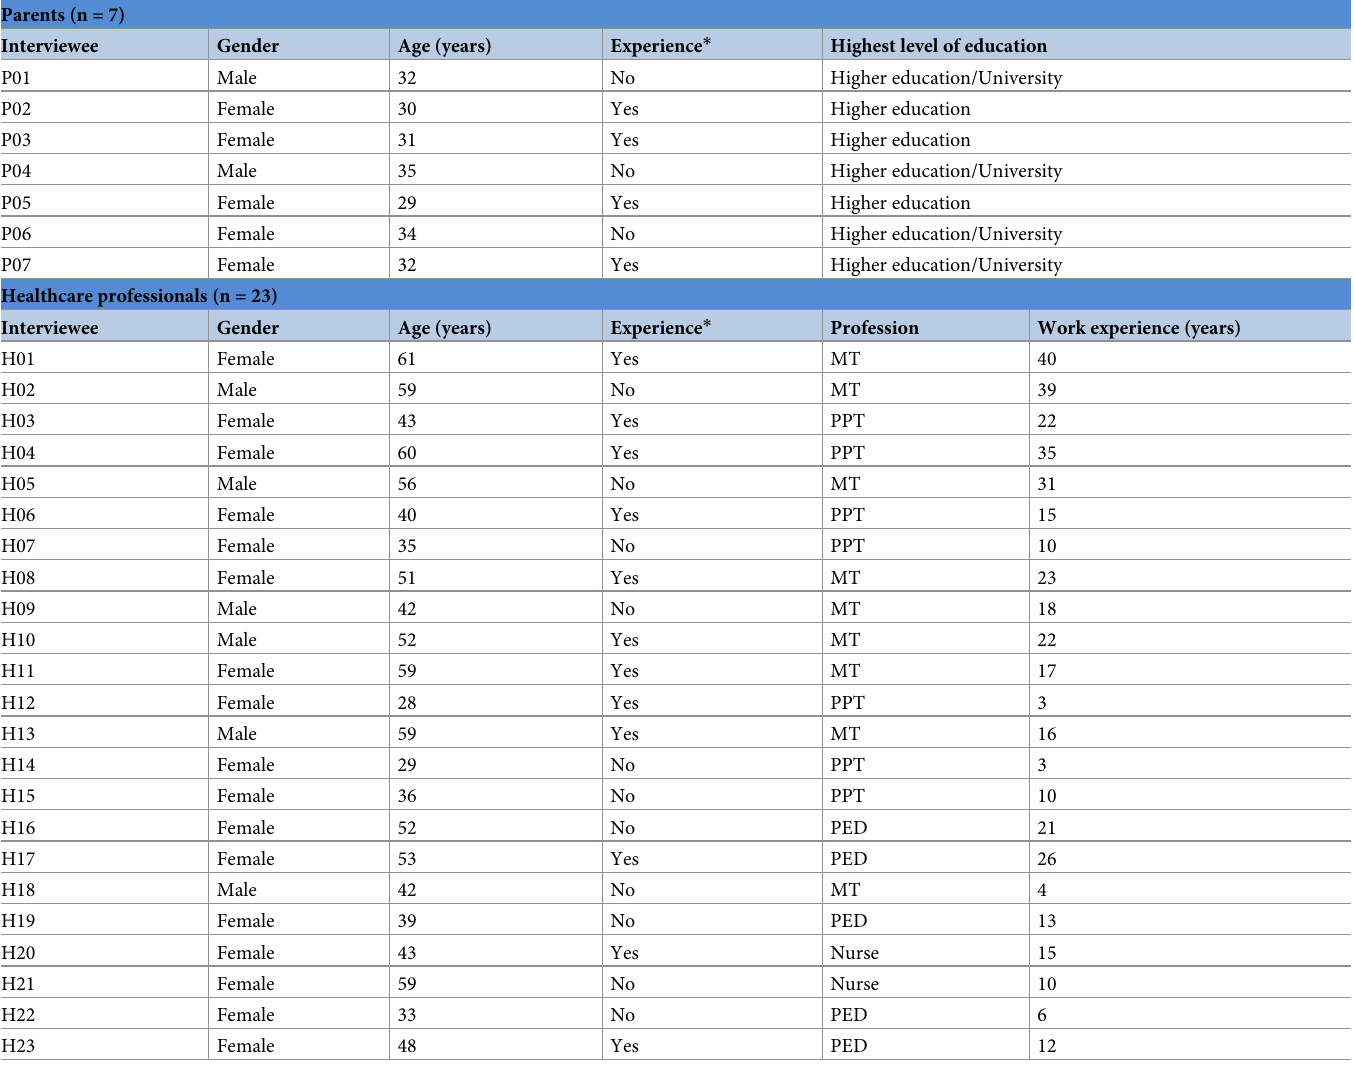
Table 2. Characteristics of interviewees (n =